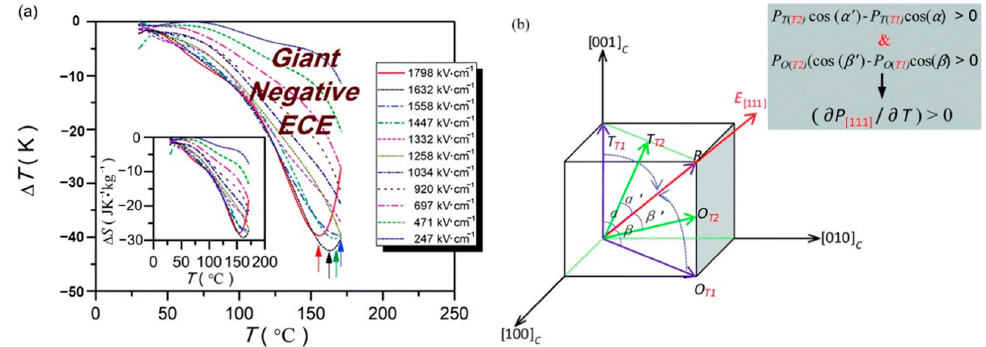
Figure 27. Electrocaloric effect of the BCT–BMT thin films. ( a ) ∆ T ( T ) at selected electric fields. Inset: ∆ S ( T ). ( b ) Phase transition diagram of tetragonal/orthorhombic to rhombohedral under the electric field. Inset: Positive pyroelectric coefficient along (111) direction. Reprinted with permission from [92]. Copyright 2019 The Royal Society of Chemistry.